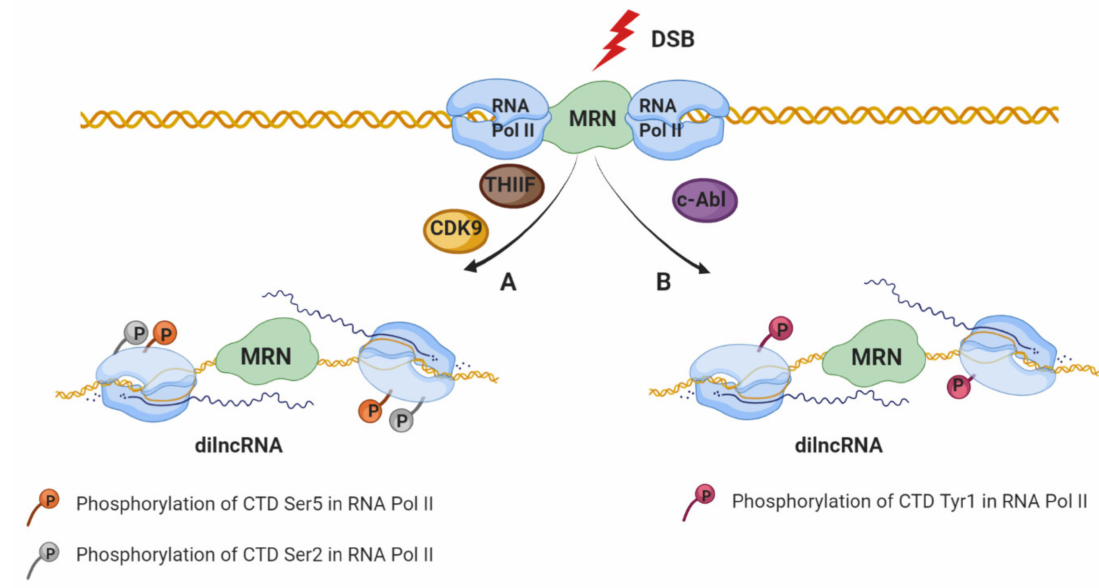
Figure 1. TwomodelsofdilncRNAsproduction.Inresponsetodouble-strandbreaks(DSB),MRNcomplex recognizes the DNA damage and recruits RNA Pol II through binding with its RPB1 subunit. ( A ) Damage-induced RNA (dilncRNA) are transcribed by RNA Pol II phosphorylated on the carboxy-terminal domain (CTD) at Serine5 or Serine2 residue that regulates elongation and RNA processing. ( B ) Transcription of dilncRNA is stimulated by c-Abl which is capable of inducing phospho-marks of RNA Pol II predominantly at CTD